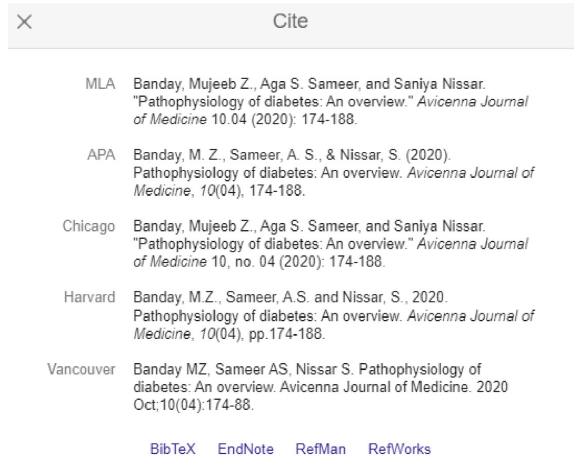
Figure 11: A Google Scholar screenshot of different styles of formatting of